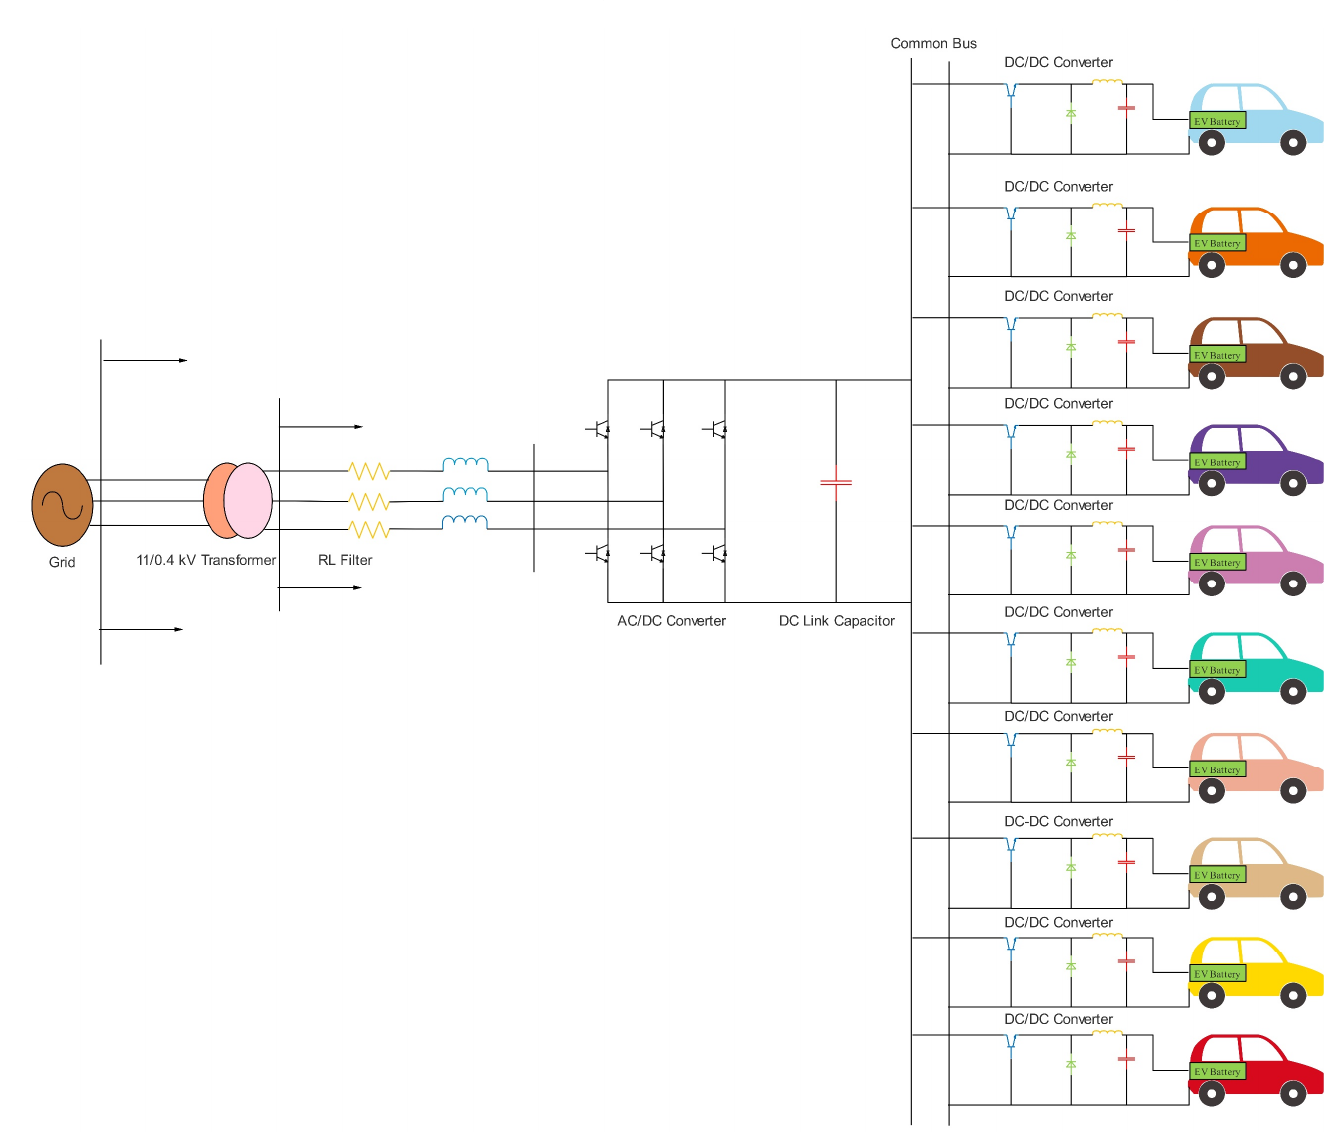
Figure 1. Configuration of a grid-connected EV system.